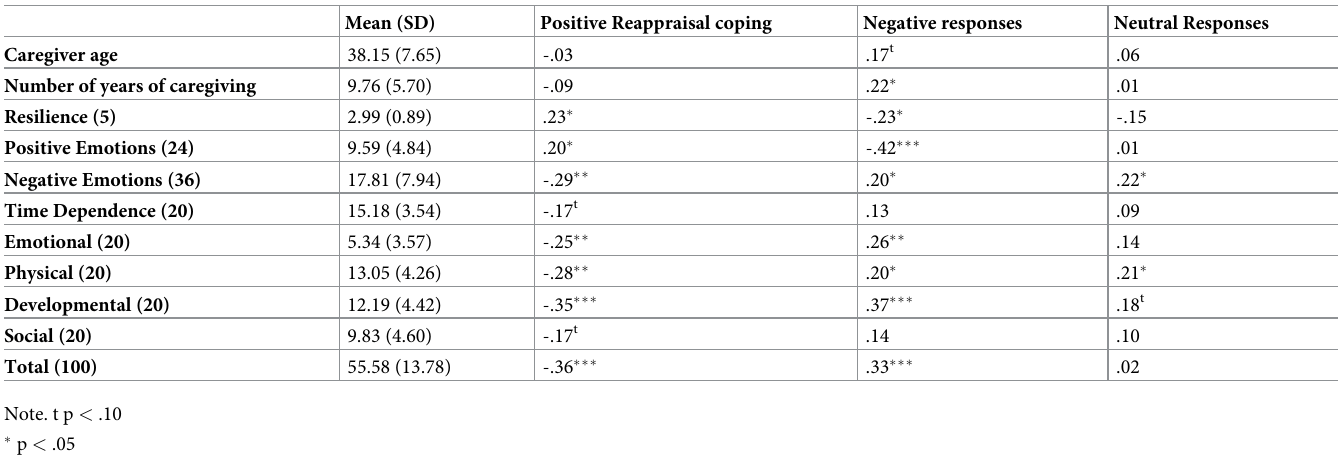
Table 2. Zero-order correlations between responses to PRCI items and caregiver characteristics, resilience, emotional wellbeing, and caregiver burden. Mean (SD) Positive Reappraisal coping Negative responses Neutral